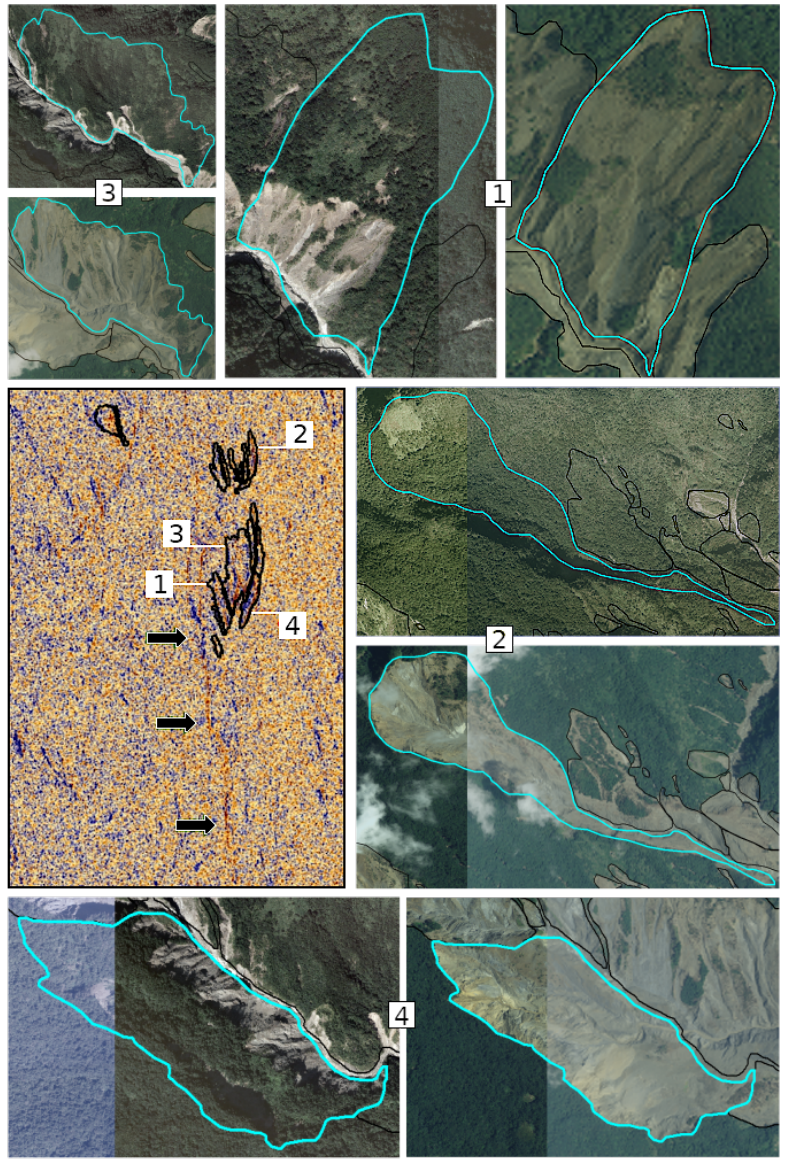
Figure 6. The slant-range LR index image covering the larger Putanpunas river catchment, where areas outlined by thin black boundaries indicate historical landslide areas. The linear cluster indicated by black arrows refers to the Lao-Noan river. The optical images acquired before and after the typhoon over the four sites are indicated by labels ( 1 – 4 ), showing that landslides occurred after the typhoon